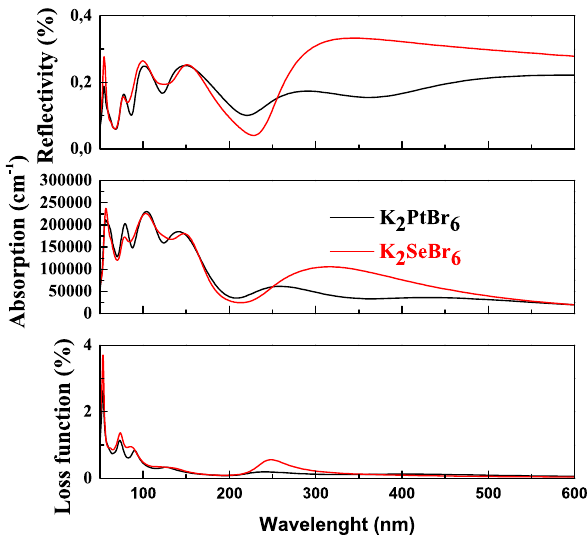
Figure 10. The reflectivity, absorption and loss function in K 2 SeBr 6 and K 2 PtBr 6 .